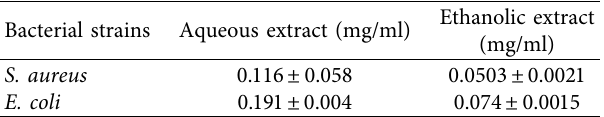
Table 5: Minimum inhibitory concentration (MIC) of aqueous and ethanol extracts of M.